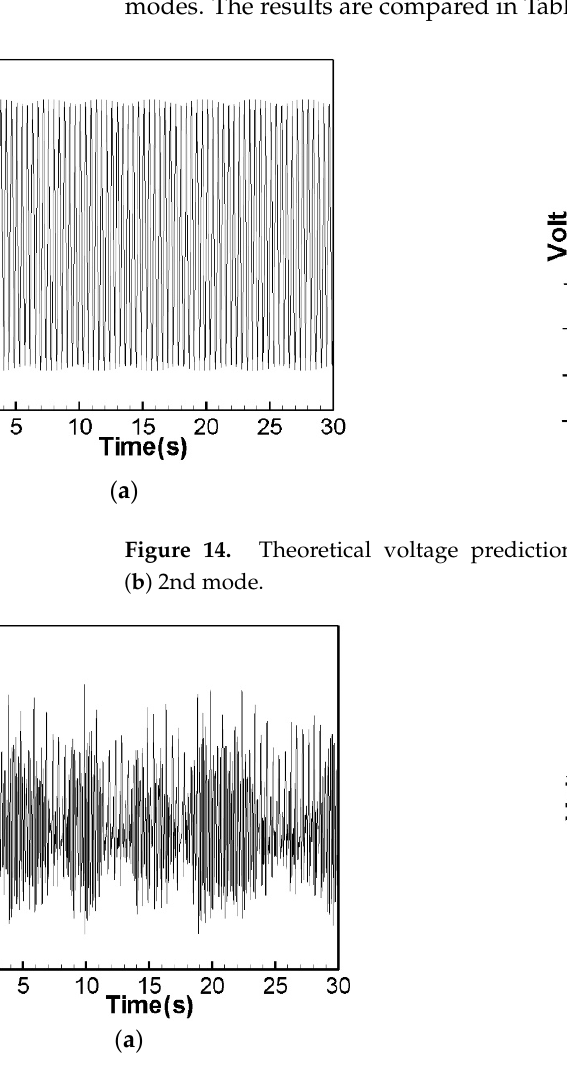
Figure 15. Experimental voltage output for “linear” frequency excitation. ( a ) 1st mode, ( b ) 2nd mode.